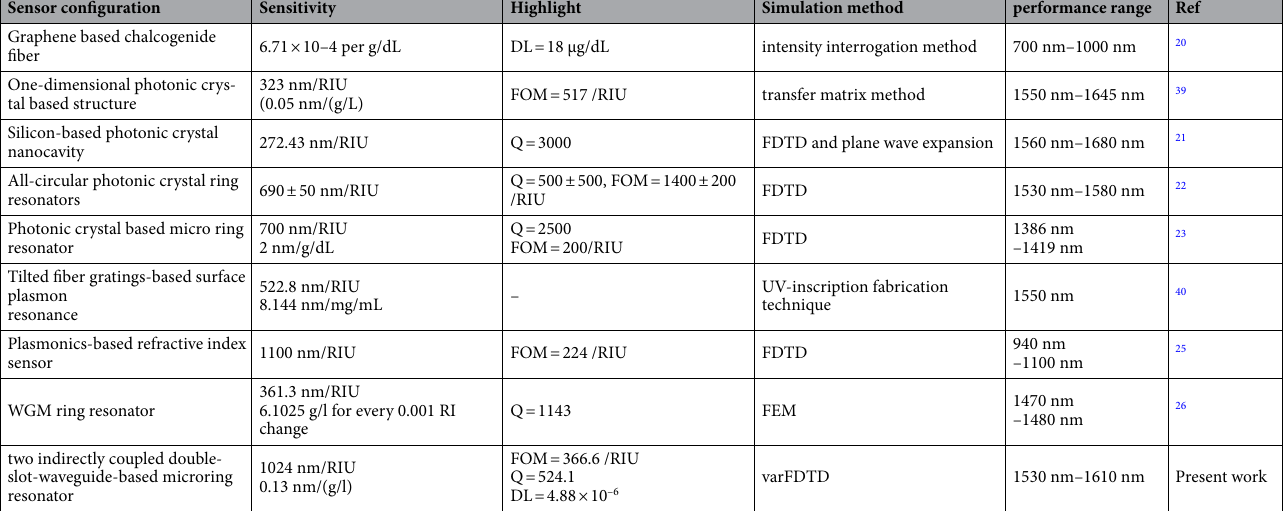
Table 3. Comparative sensitivity of different optical based sensors for detection of hemoglobin concentration. Here, DL, FOM and Q stand for the detection limit, a figure of merit and quality